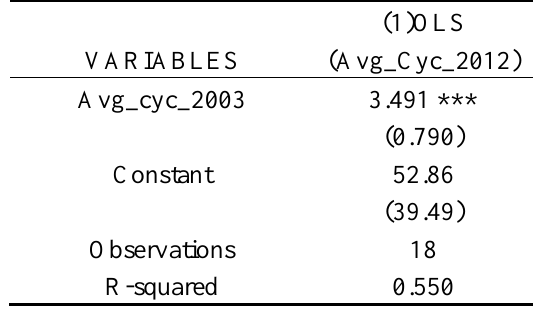
Table 3. Regression results between cyclist movement in 2003 and cyclist movement in